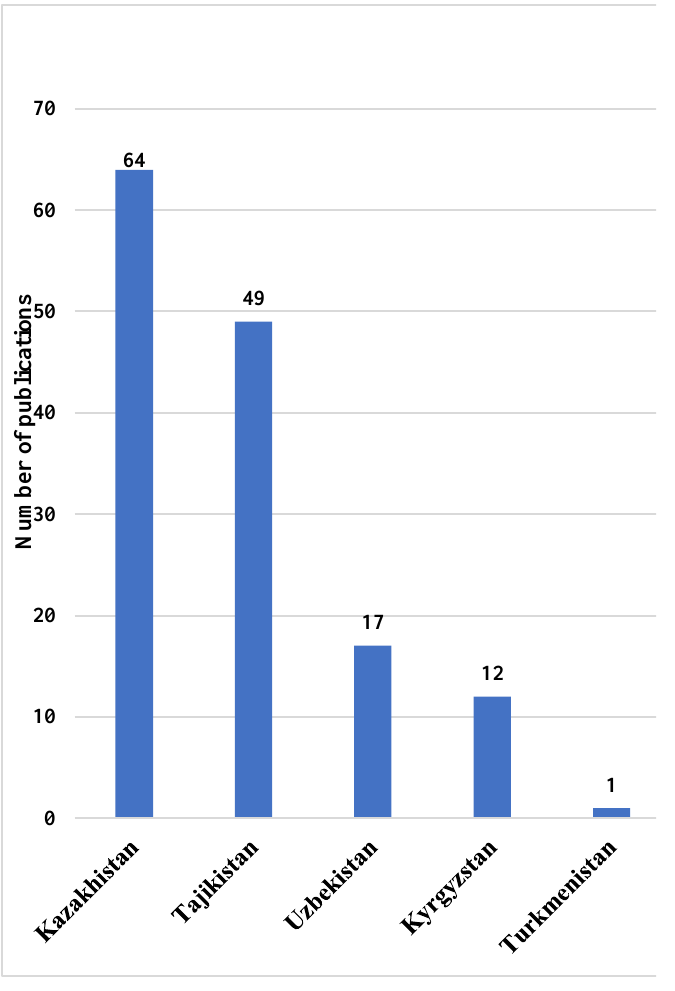
Figure 3. Distribution of retracted